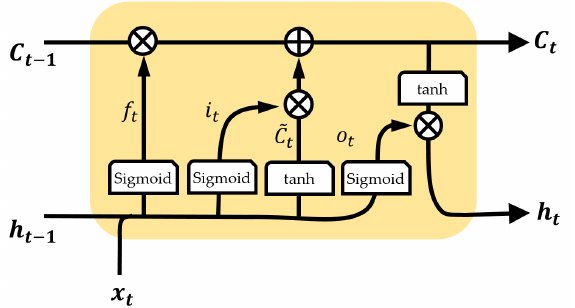
Figure 2. Structure of the fundamental LSTM